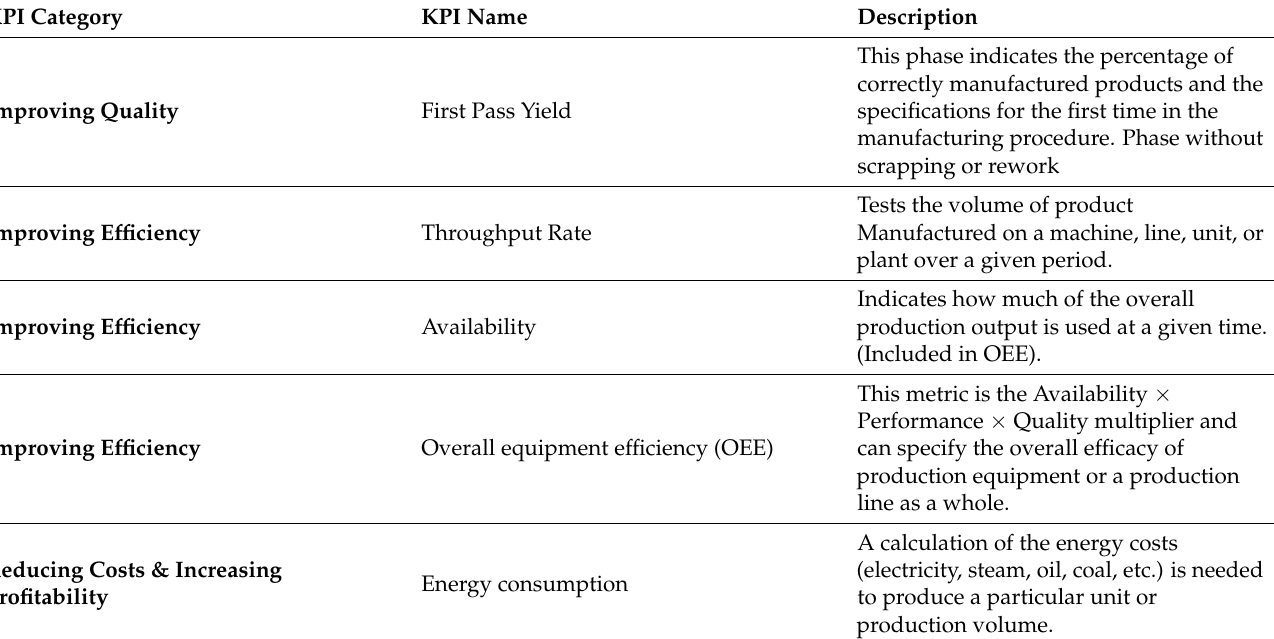
Table 3. Most Common KPIs used in industry.